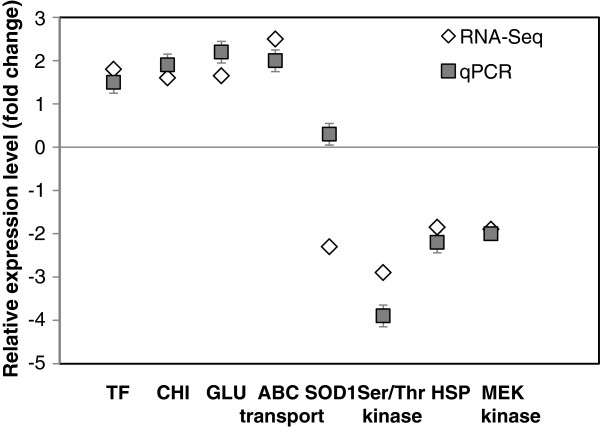
Comparison results of RNA-seq (◊) and qRT-PCR (■ ). Expression profiling of TF, CHI, GLU, ABC transporter, SOD1, Ser/Thr kinase, HSP, MEK kinase genes were examined by RNA-Seq and qPCR in genes in M. fructicola cells during interaction with P.digitatum (Mf-Pdig). Vertical lines represent standard error for an average of three biological replicates.